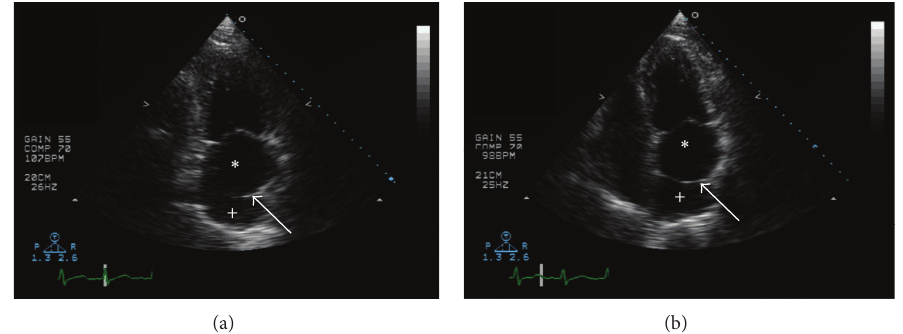
Figure 2: Transthoracic echocardiogram: 2-chamber view (a) and 4-chamber view (b) showing the left atrium divided into proximal (+) and distal ( ∗ ) chambers by a fenestrated membrane (arrow).